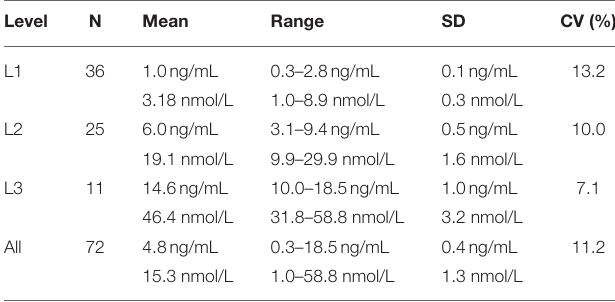
TABLE 3 | Inter-assay coefficients of variation (CVs) at low (L1), intermediate (L2), high (L3), and all concentrations of canine serum progesterone for a point-of-care analyzer.